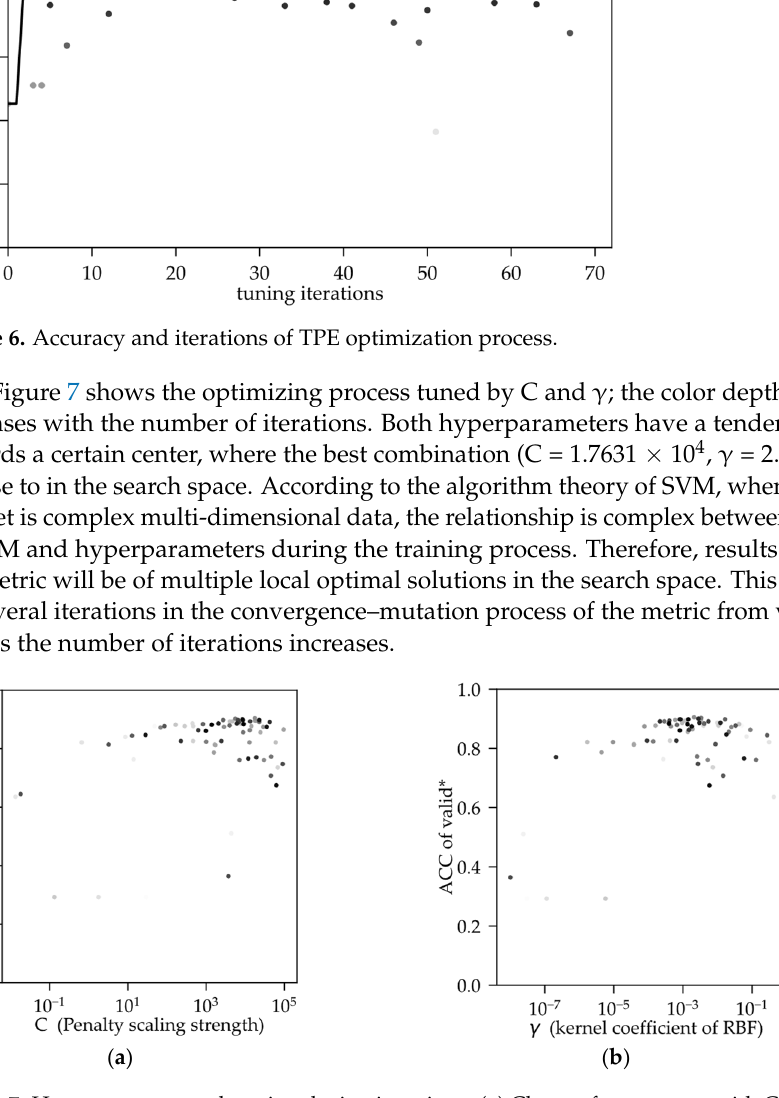
Figure 7. Hyperparameters changing during iterations. ( a ) Change for accuracy with C and iterations. ( b ) Change for accuracy with γ and